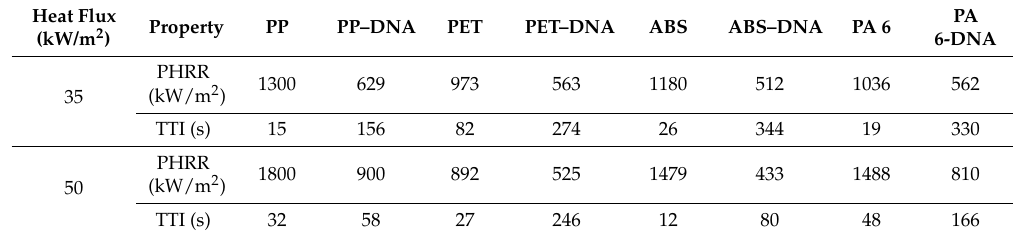
Table 10. Flammability of polymers surfaced-treated with DNA.